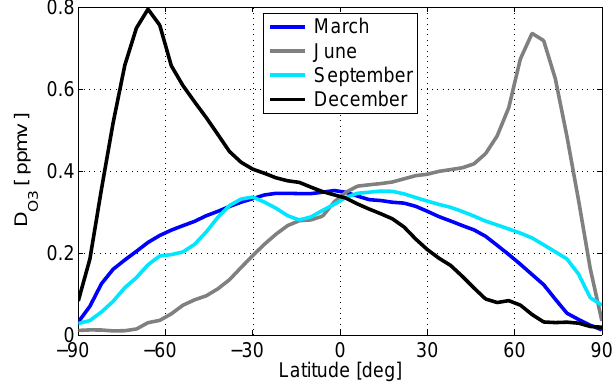
(Eq. 3) as a Figure 4. Zonal mean of peak-to-valley difference D O 3 function of latitude at 5hPa modelled by WACCM. The lines show for March, June, September and December. monthly mean D O 3 sphere by thermolecular Reaction